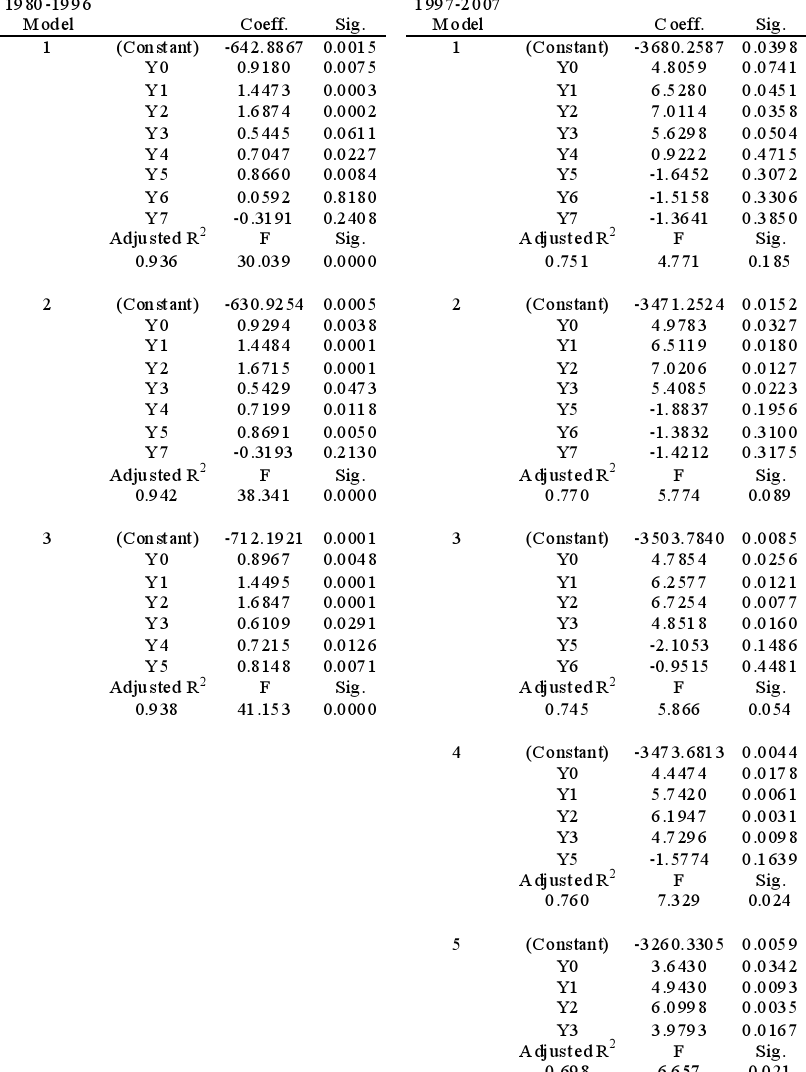
Table 1. Results of the stepwise multiple linear regression with backward selection (SPSS v. 15.0). The seven preceding years (Y1-Y7) plus the current year (Y0) were included in the analyses as dependent variables. For each model (step) the unstandardized coefficients with degree of significance and the basic statistics are presented. Sábalo catch was the dependent variable. The criterion for the probability of F-to-remove was > .100). Dependent variable: